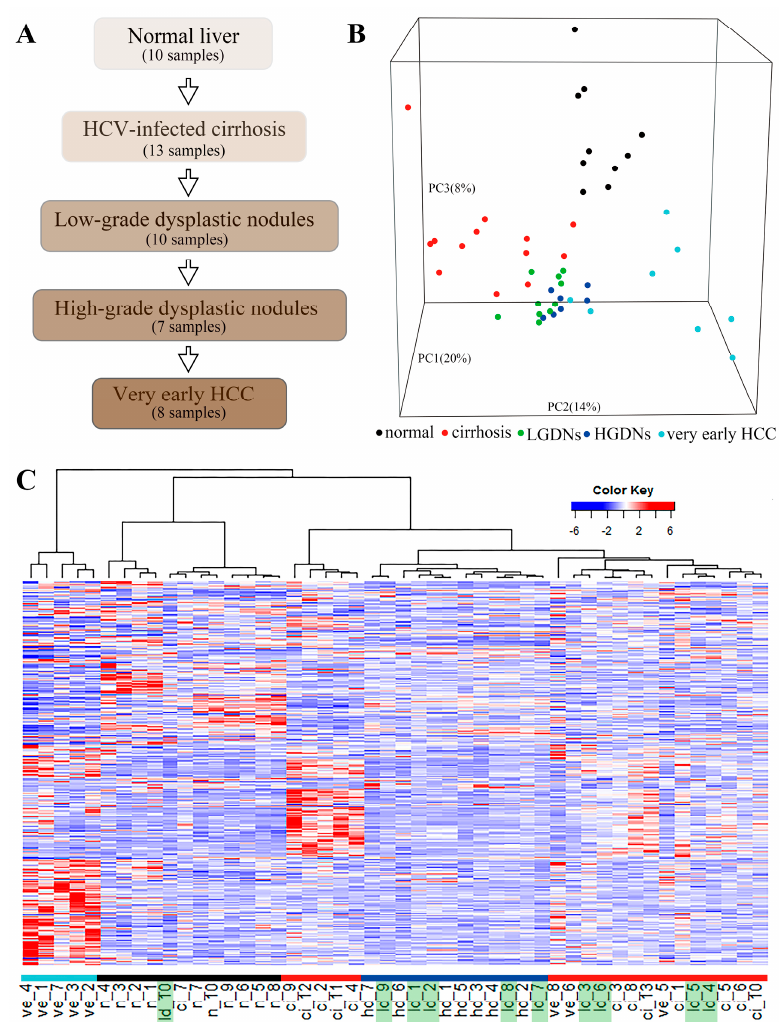
Figure 1. The progression of hepatitis C virus (HCV)-induced hepatocellular carcinoma (HCC) and gene expression profiling. ( A ) A schematic diagram shows the HCV-induced HCC development. ( B ) A three-dimentional image shows principal component analysis (PCA) for clustering 48 samples along HCC development. Each small spot represents the principal component (PC) score along the top three principle components for each sample. ( C ) Unsupervised hierarchical clustering of 48 tissue samples using the Pearson correlation coefficient (PCC) distance. Similar to ( B ), low-grade dysplastic nodules (LGDNs) samples are not grouped together but dispersed into cirrhosis and high-grade dysplastic nodules (HGDNs) groups. n: Normal; ci: Cirrhosis; ld: Low-grade dysplastic nodules; hd: High-grade dysplastic nodules; ve: Very early HCC. The colored bars mark clusters: black, normal; red, cirrhosis; dark blue, HGDNs; light blue, Very early HCC. Dispersed LGDNs samples are highlighted in green.